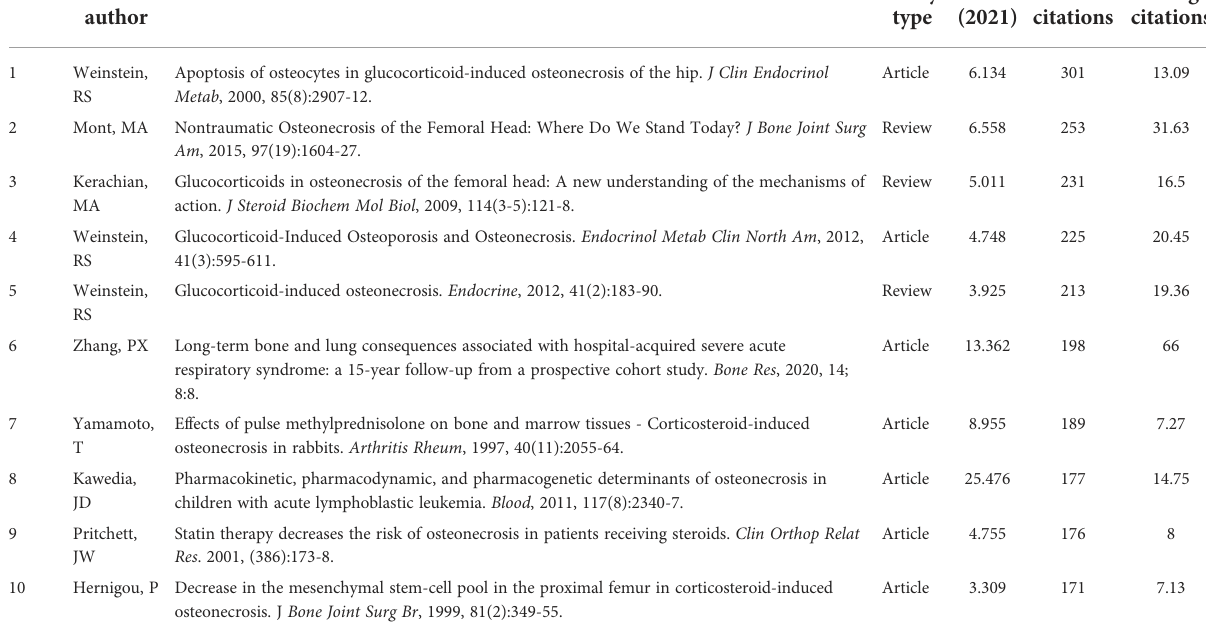
TABLE 2 Top 10 highest cited articles on SONFH from 1992 to